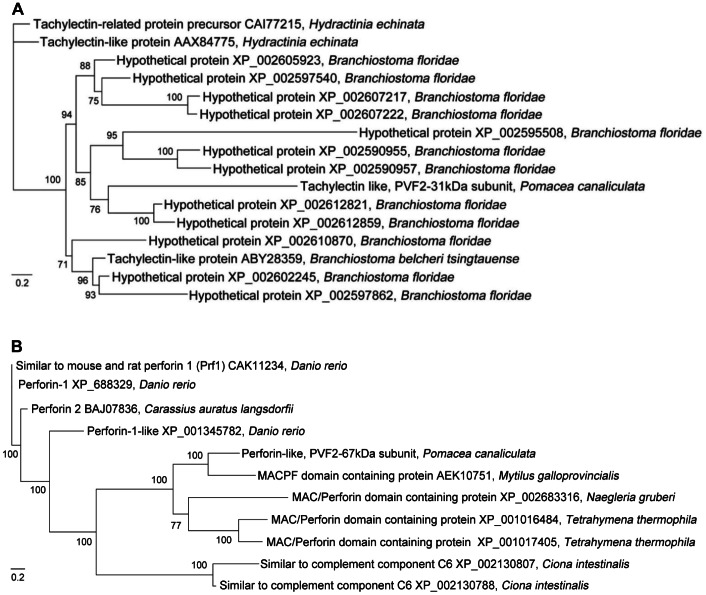
Bayesian phylogenetic tree of light (A) and heavy (B) PcPV2 subunits of Pomacea canaliculata.Numbers above branches represent Bayesian posterior probabilities of finding a given clade. Scale bar, 0.2 nucleotide substitution.